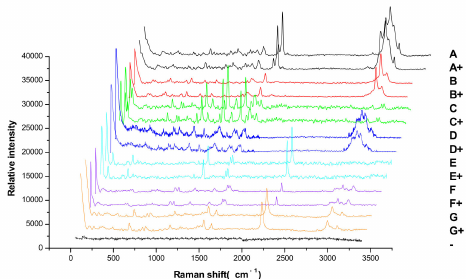
Figure 4. Raman spectra of the seven pesticides in the simulated positive sample by TLC-RIM (A, B, C, D, E, F, and G: Abamectin, Methomyl, Carbendazim, Imidacloprid, Chlorothalonil, Azoxystrobin, and Acetamiprid, respectively. A + , B + , C + , D + , E + , F + , G + : Simulated positive samples containing A, B, C, D, E, F, and G; − : Negative